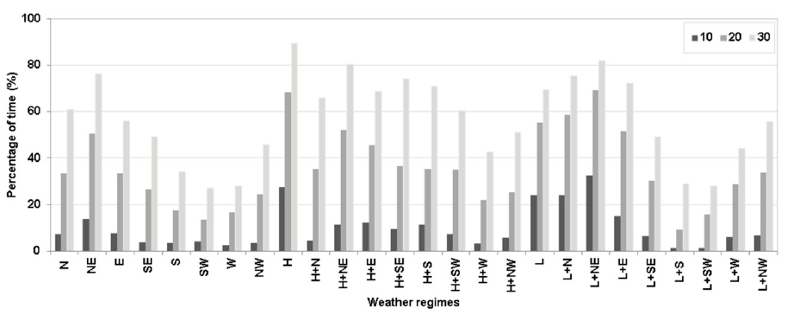
Figure 11. Percentage of events with low generation (below 10%, 20%, and 30% of the total installed capacity).